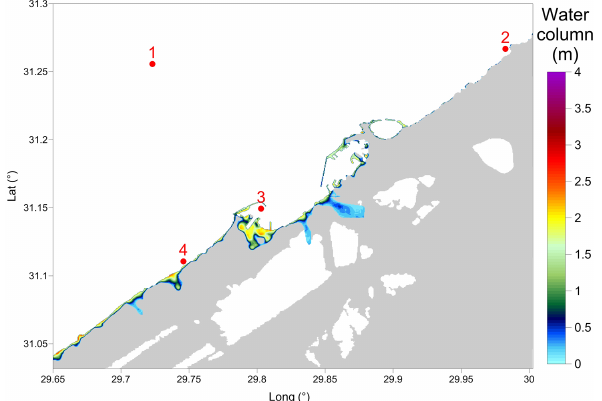
Figure 8. Sea surface maxima for the EHA source, zoomed in on the area of Alexandria with grid 3 (200m